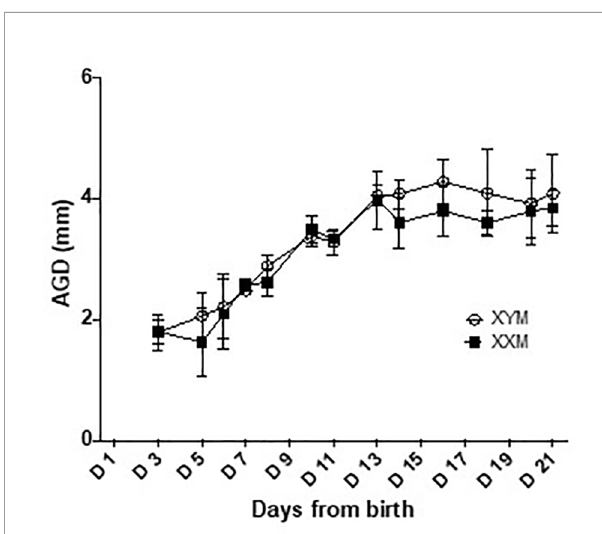
FIGURE 6 | Anogenital distance development in FCG male pups. Anogenital distance was measured daily until weaning. Data are presented as the mean ± SD. No signi fi cant difference was found between XYM and XXM genotypes on any day analyzed by repeated measure 2-way ANOVA with post-hoc Sidak corrections for multiple comparisons. n = 4 XXM and 5 XYM pups.